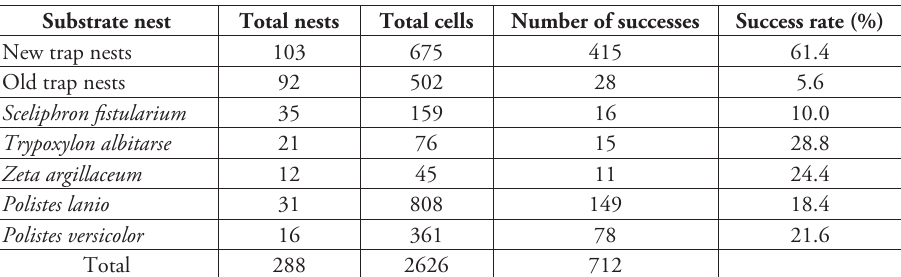
Table 1. Nesting success of Trypoxylon nitidum in different substrates. In new trap nests, the number of successes is estimated from the number of known successes (349) and the projected fate of 80 live pupae, as explained in the text. In all other substrates, the number of successes is directly known. Old trap nests are those that were previously utilized by T. nitidum